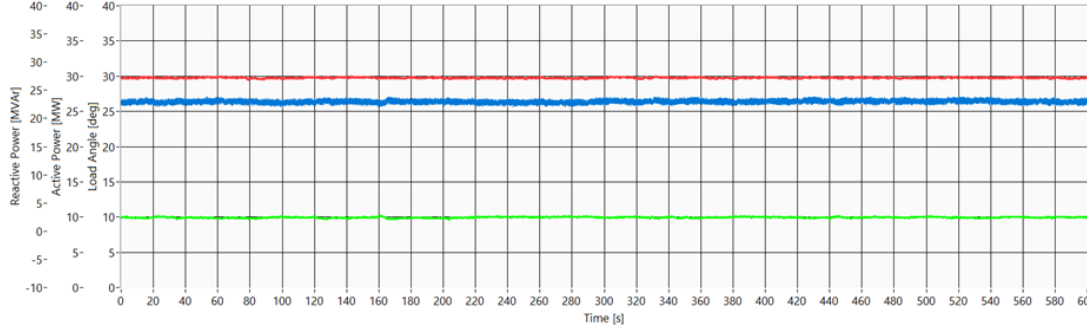
Figure 16. Testing results of the load angle measurement algorithm of the synchronous generator under steady-state conditions. The red curve represents the active power measurements, the green curve represents the reactive power measurements and the blue curve the load angle measurements.